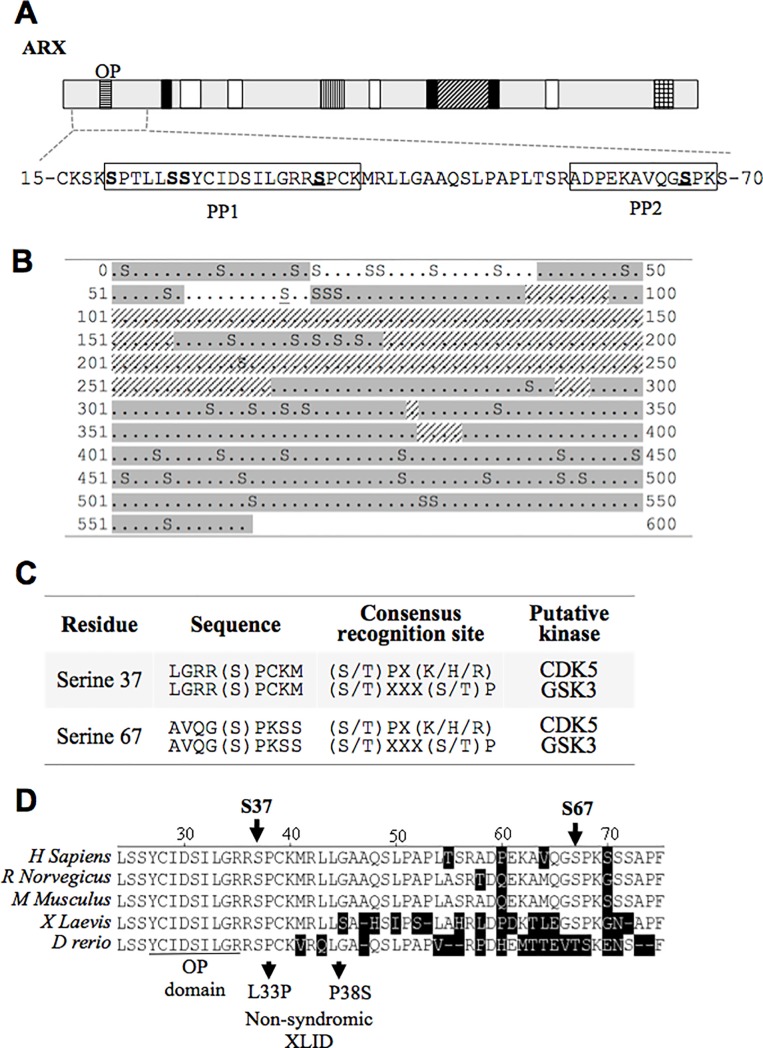
Serine phosphorylation sites in the N-terminus of ARX.(A) The position of phosphopeptides (PP1 & PP2) identified by LC-ESI-IT-MS/MS analysis is indicated by the boxes. The phosphorylated residues S37 and S67 are bold and underlined. (B) Peptide sequence coverage of ARX-WT by MS analysis. Matched peptides in ARX-WT peptide sequence coverage are shown highlight by grey boxes; phosphopeptides and novel phosphorylation site (underlined) detected by MS analysis are indicated in white boxes. Positions boxed in hatched lines were not covered by the MS analysis. (C) NetPhos 3.1 in silico prediction of ARX putative phosphorylation sites. (D) Orthologous protein sequence alignments of ARX protein with non-conserved amino acids shaded in black. Octapeptide domain of ARX is indicated by a dotted lined box. The position of serine phosphorylation sites–S37 and S67 are indicated by black arrows. Below the alignment, naturally occurring ARX mutations causing X-linked ID.